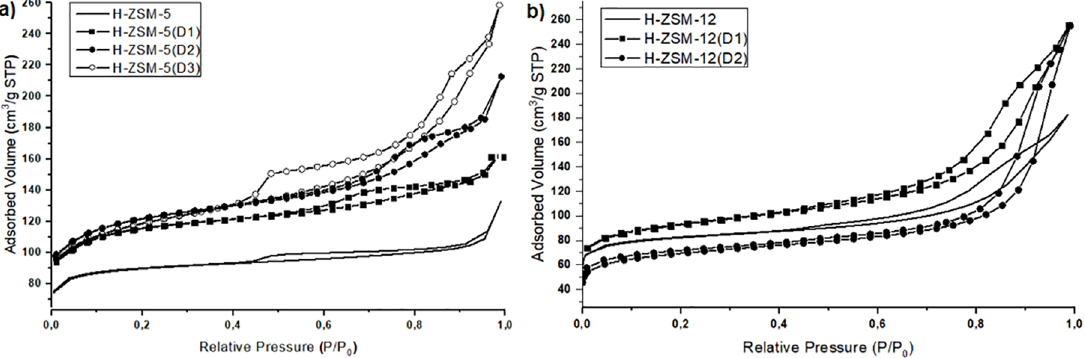
Figure 2. N2 adsorption and desorption isotherms.a) H-ZSM-5 and b) H-ZSM-12.